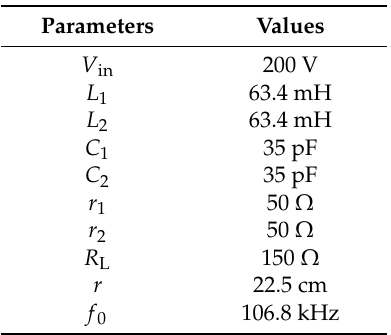
Table 1. Parameters of the single-wire ECPT